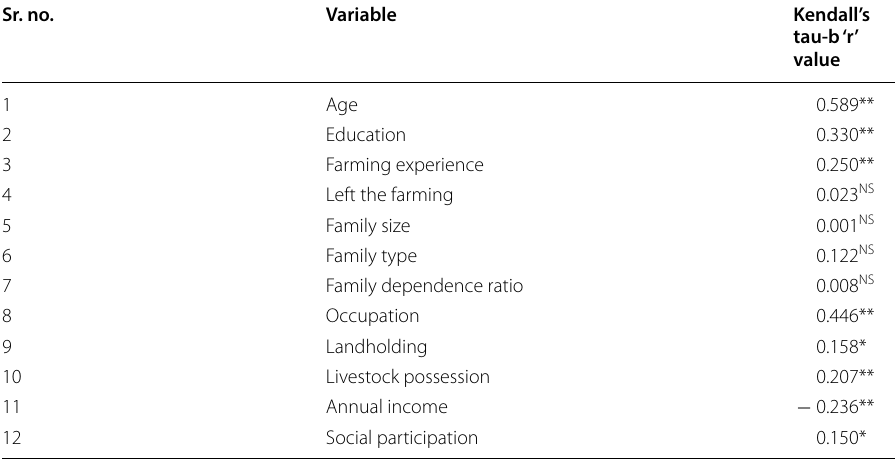
Table 4 Correlation (r) between profile of the agricultural landholders and factors to avoid agriculture as a profession ( n =